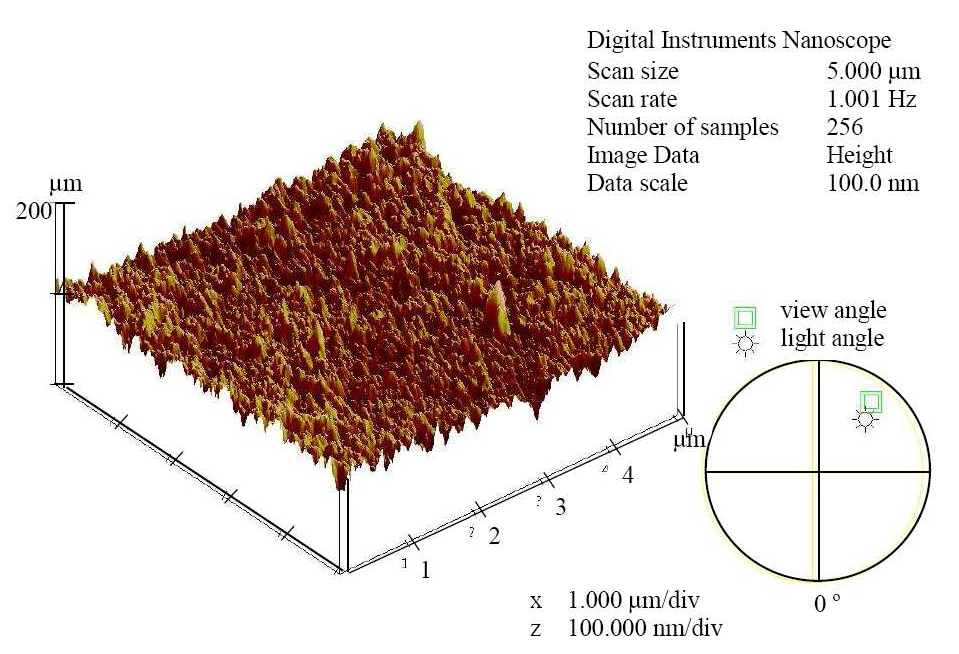
Figure 5. AFM image of MIP-ITO sensor after rebinding in 5 mM theophylline for 25